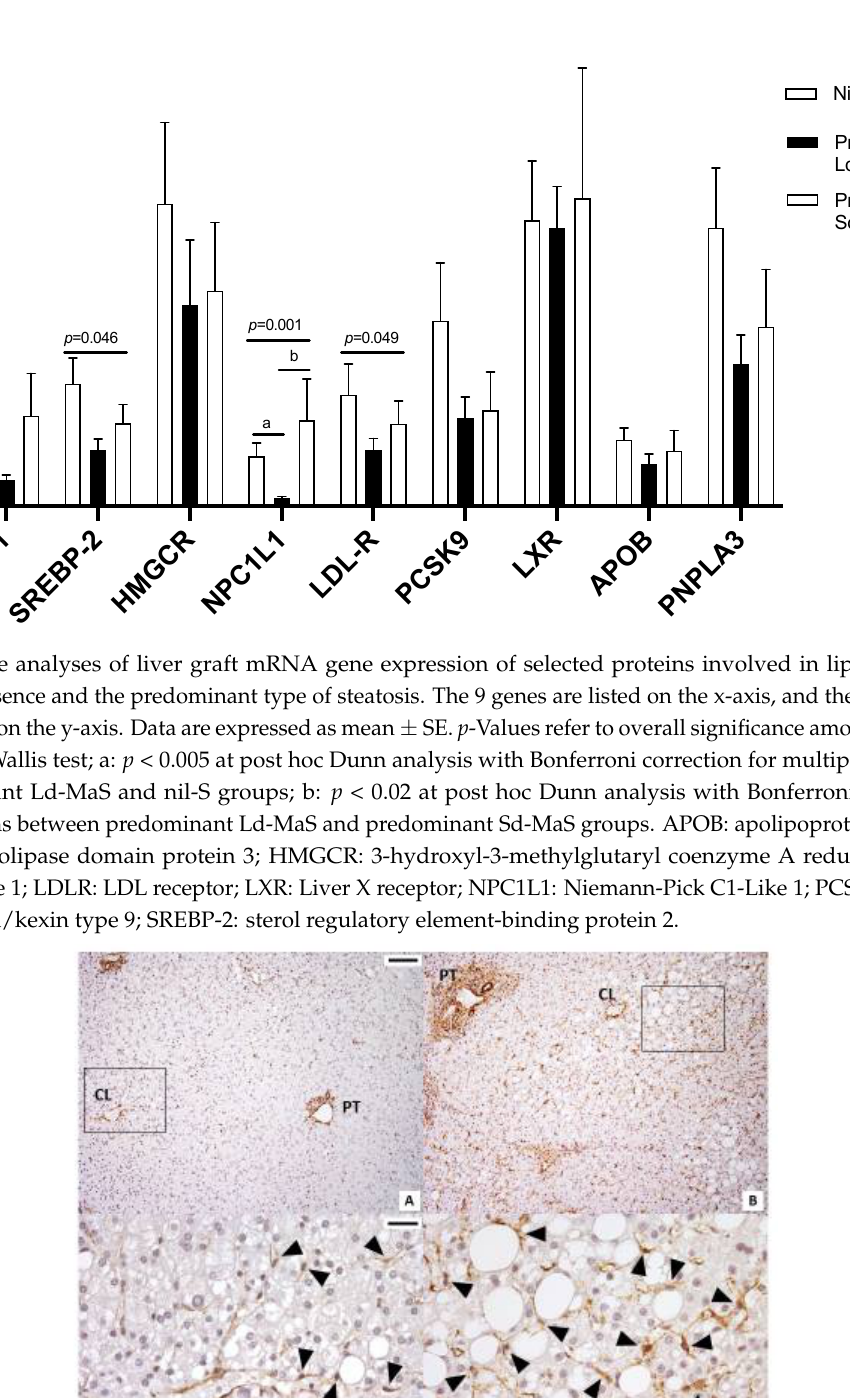
Data are expressed as median and interquartile range. Pred. Ld-MaS: predominant large droplet macrovescicular steatosis; Pred. Sd-MaS: predominant small droplet macrovescicular steatosis. HSC: hepatic stellate cell. p -values numbers marked in bold indicate numbers that are significant at the p < 0.05 level